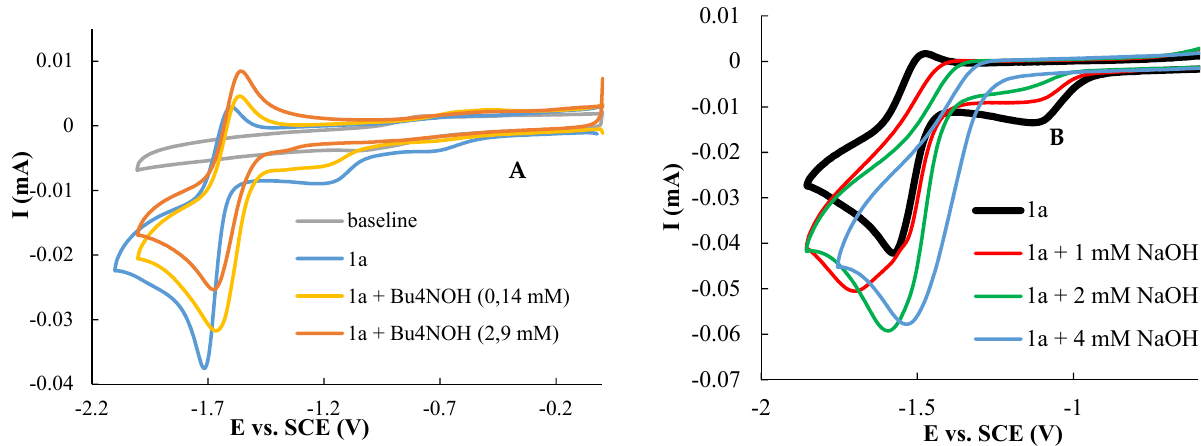
Figure 8. ( A ) CVs obtained in the presence of compound 1a (3 mM) in a solution of DMF (0.1 M Bu 4 NBF 4 ) v = 0.1 Vs − 1 with the addition of an aqueous solution of Bu 4 NOH. ( B ) CVs obtained in the presence of compound 1a (3.3 mM) in a DMF solution (0.1 M Bu 4 NClO 4 ) v = 0.1 Vs − 1 with the addition of an aqueous solution of NaOH.